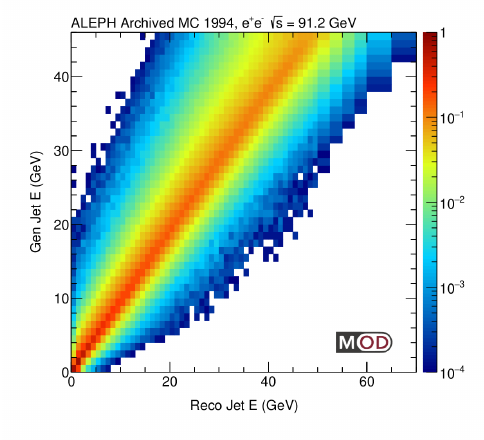
Figure 1 . Response matrix for jet E . The matrix is row-normalized: the color scale indicates the probability density of a given generator level jet being smeared into a different reconstructed level jet.